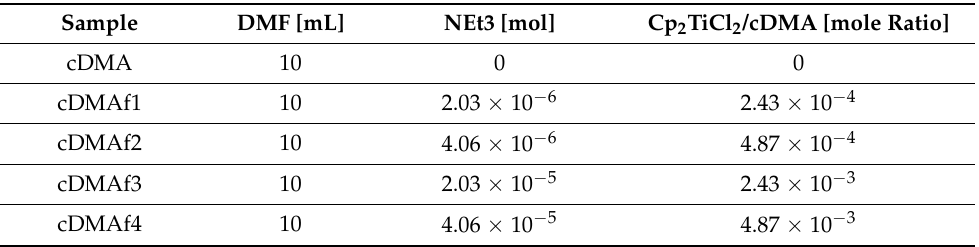
Table 1. Functionalization conditions for copolymers functionalized with the organometallic complex